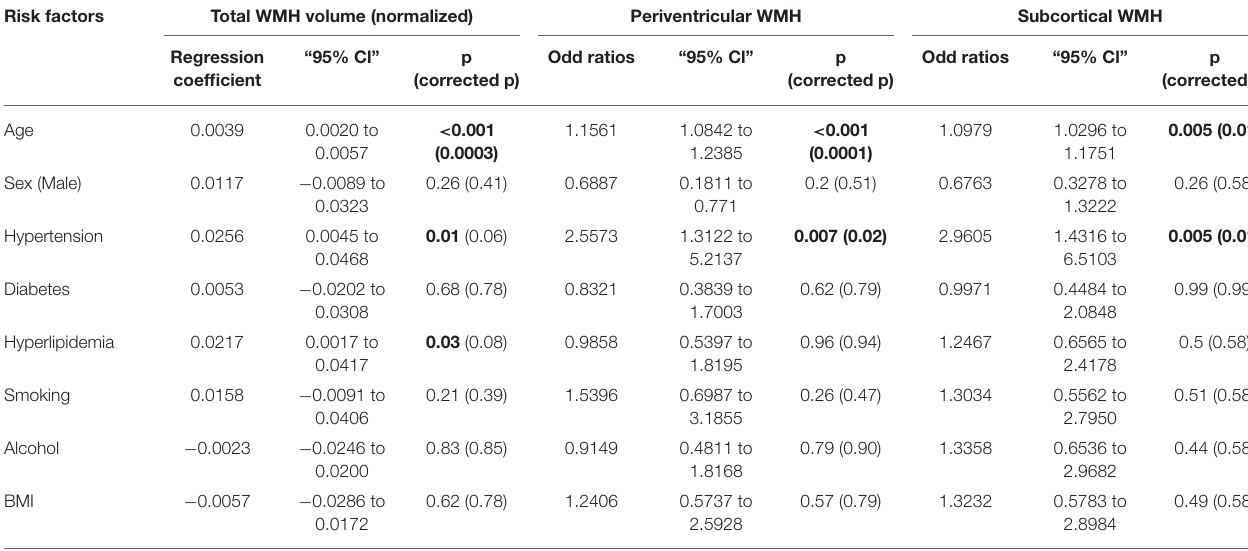
TABLE 4 | Associations between multiple risk factors and white matter hyperintensities